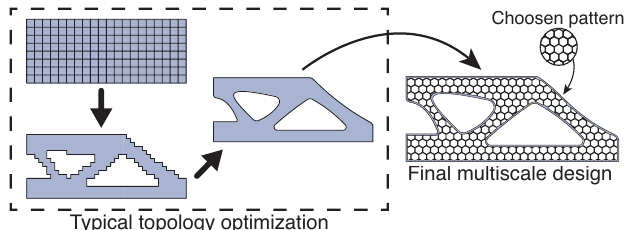
Figure 10. Process to tailor stiffness using the multiscale process that combines Topology Optimiza- tion with Cellular Materials.